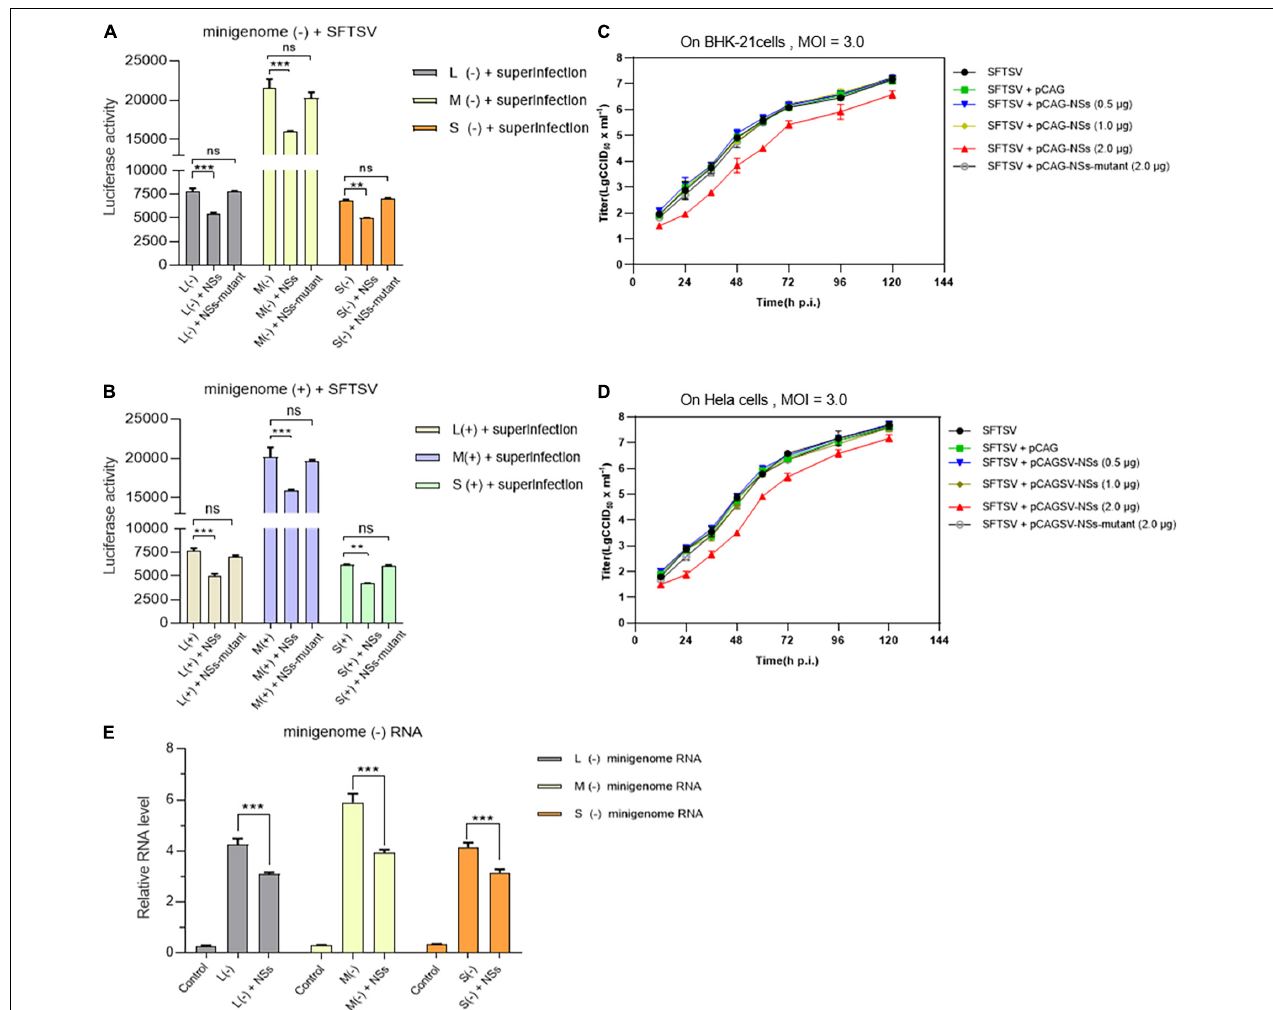
FIGURE 7 | NSs exert a negative regulatory effect on virus-like RNA synthesis and virus replication in both immunodeficient cells and non-immunodeficient cells. To further investigate the role of overexpressed NSs in virus-like RNA synthesis, virus replication, and the correlation between NSs regulating RNA synthesis and antagonizing host antiviral responses, we adopted superinfection and infection methods to analyze virus-like RNA synthesis and virus replication under different conditions. Briefly, when BHK-21 cells transfected with 1.0 µ g of L/M/S minigenome (–) or minigenome (+) and 2.0 µ g of NSs- or mutant NSs-expression plasmids were infected with SFTSV at a MOI of 3.0, the luciferase activity (Luc. Act.) of the indicated groups were measured at 48 hpi, respectively. Data are presented as the mean ± SEM ( n = 3) for minigenome (–) (A) and minigenome (+) (B) . ** p < 0.01; *** p < 0.001; ns, non-significant. The immunodeficient (BHK-21) or non-immunodeficient cells (Hela) were transfected with various amounts (0.5, 1.0, and 2.0 µ g) of NSs- or mutant NSs-expression plasmids DNA, respectively. At 12 hpi, the indicated cells above were infected with SFTSV at a MOI of 3.0, respectively, and the supernatants were harvested at 12, 24, 36, 48, 72, 96, and 120 hpi. The supernatants then were titrated for infectious virus titration (TCID 50 ) using indirect immunofluorescence assays. Infectious virus titers (TCID 50 /ml) were calculated based on the Reed and Muench method. Data are presented as the mean ± SEM ( n = 3) (C,D) . The minigenome RNA levels of L (–), M (–), and S (–) were quantified by qRT-PCR using the gene encoding GAPDH as an internal control and the relative RNA levels were presented (E) . In the qPCR analyses, relative RNA levels over the control groups (wild-type cells or the cells transfected with the control plasmids) were calculated for L (–), M (–), and S (–) minigenome RNA, respectively. Data show mean ± SEM ( n = 3). *** p <